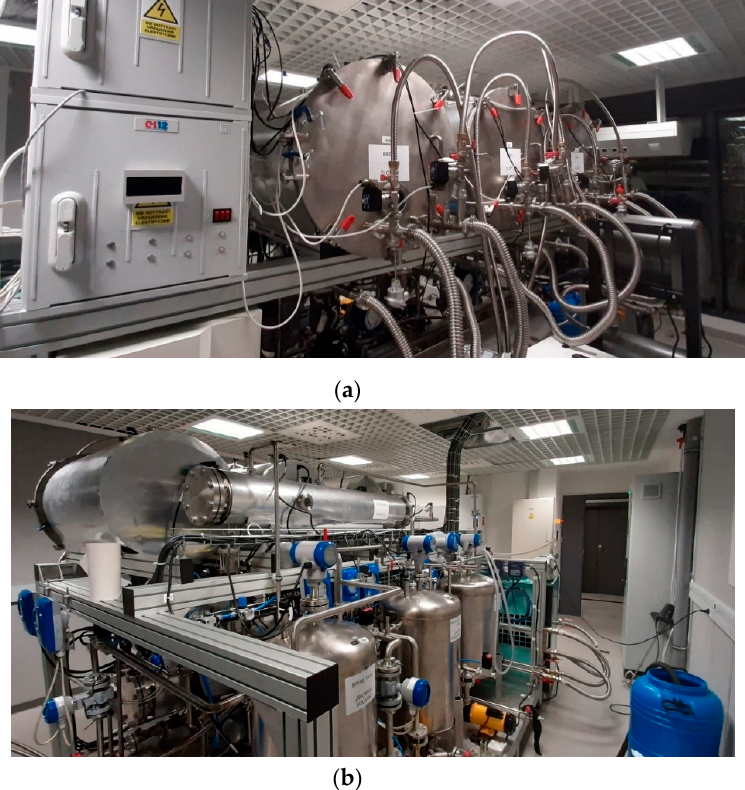
Figure 2. The picture of the investigated adsorption chiller with desalination function: ( a ) Front view, ( b ) back view.